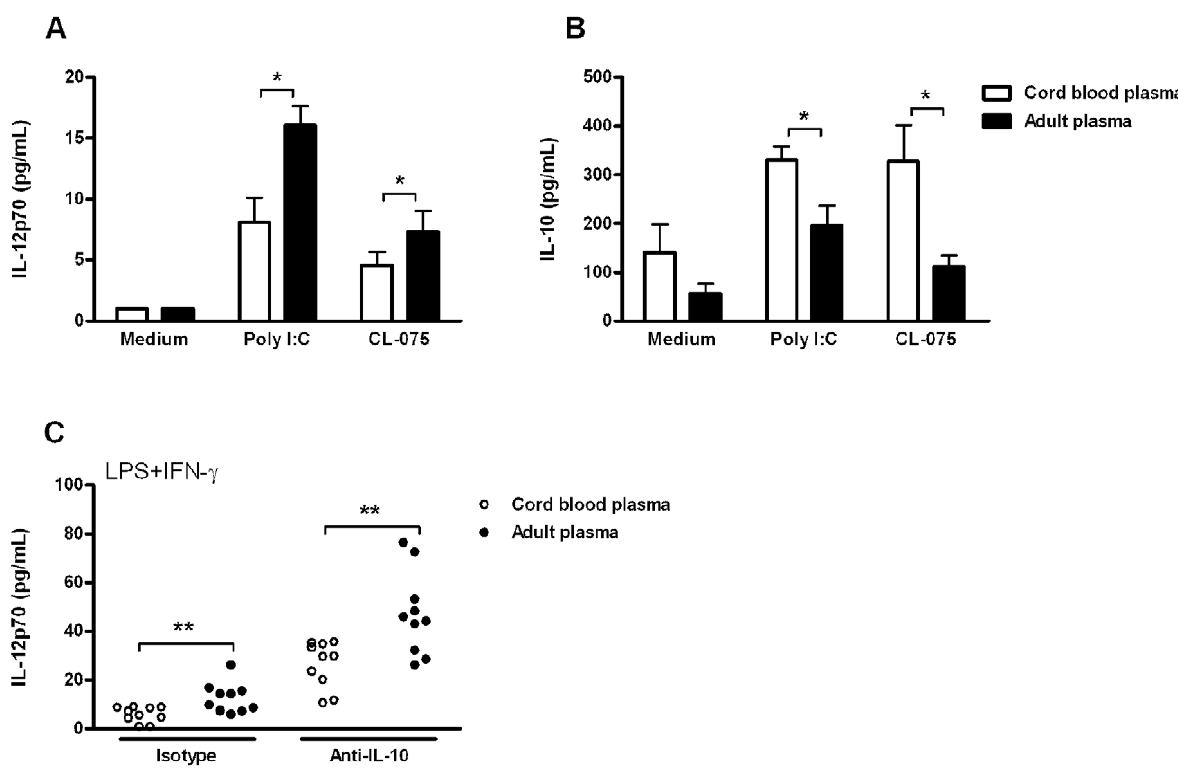
Figure 4. Cord blood plasma polarizes cytokine responses to MyD88-dependent and independent TLR agonists. A–B; Agonist-induced production of IL-12p70 (A) and IL-10 (B) by adult PBMC stimulated in the presence of 10% cord blood plasma or adult plasma. PBMC were stimulated for 24 h with medium, poly I:C (TLR3, 200 m g/mL) or CL-075 (TLR8, 10 m g/mL). After 24 h, supernatants were collected and cytokine concentrations were determined by ELISA. Bars represent mean + SEM from five different plasma samples. C; TLR4-mediated production of IL-12p70 by adult PBMC stimulated in the presence of 10% cord blood plasma or adult plasma, with or without IL-10 neutralizing antibody (1 m g/mL). Each dot represents one individual plasma sample. Data are representative of three independent experiments. *; p , 0.05, **; p , 0.01.